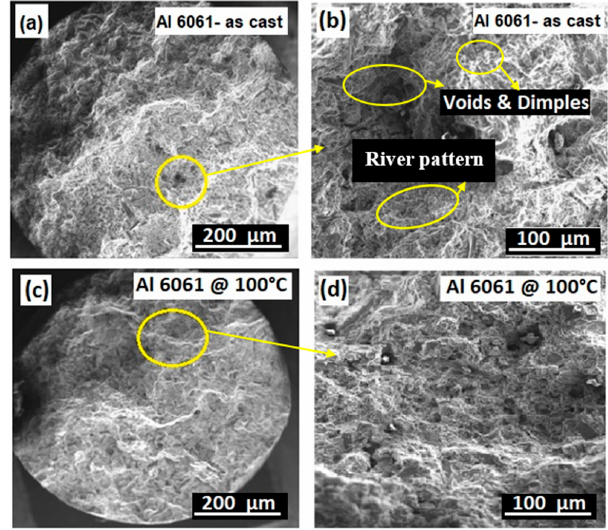
Figure 9. SEM fractographs of ( a ) as-cast Al6061 alloy ( b ) at higher magnification, ( c ) peak-aged sample at 100 °C, and ( d ) different locations at higher magnification.